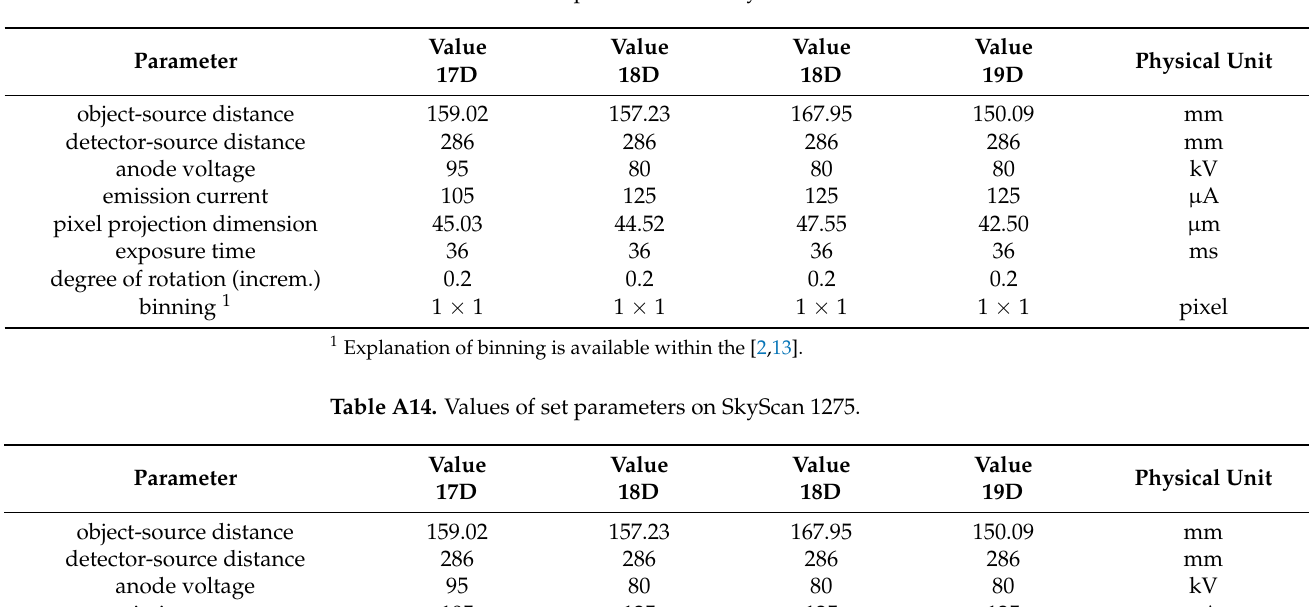
Table A13. Values of set parameters on SkyScan 1275.